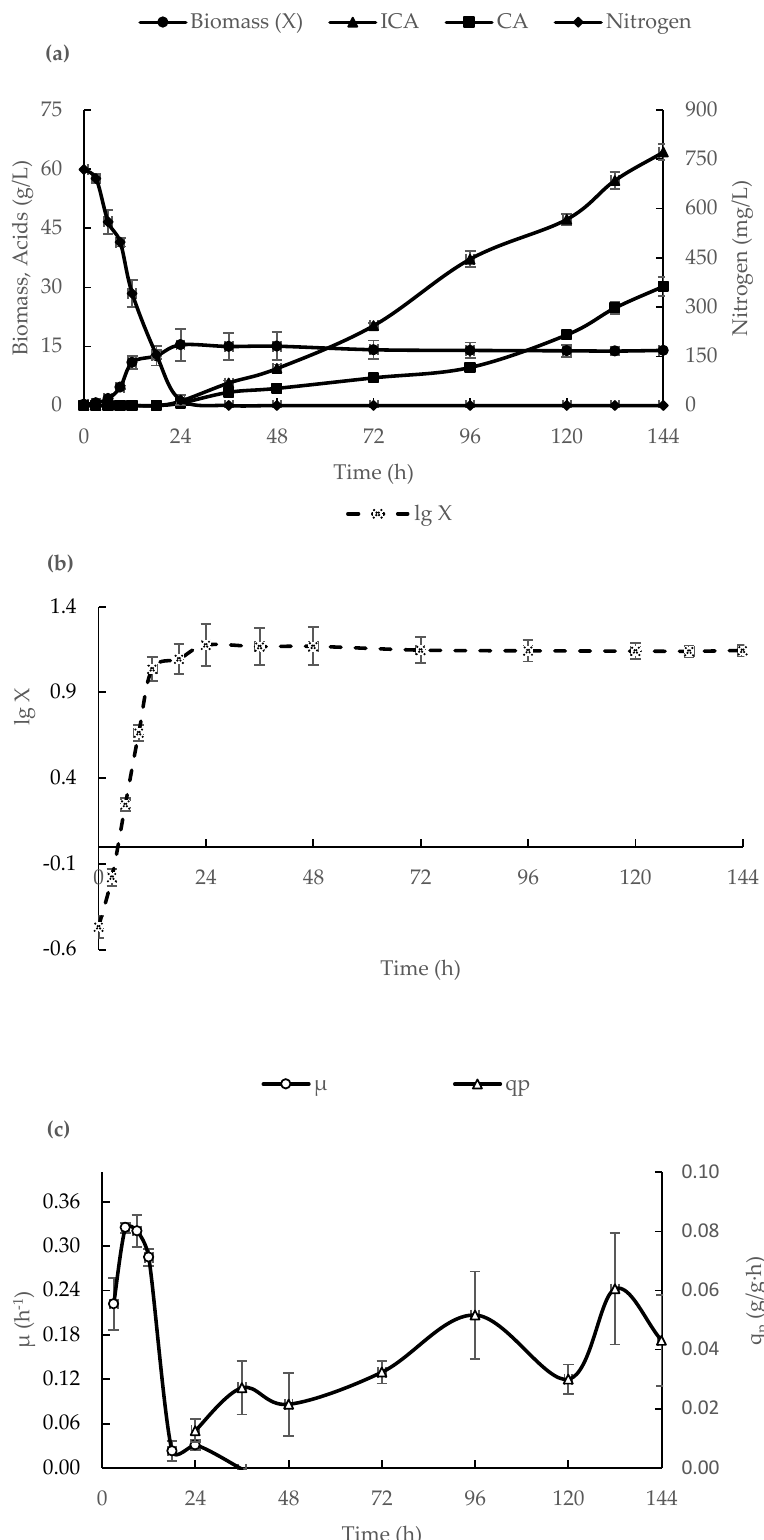
Figure 2. The dynamics of the nitrogen consumption in the medium, biomass (X) accumulation, isocitric acid (ICA), and citric acid (CA) production in Y. lipolytica VKM Y-2373 cultivated in a 10-L fermenter ( a ), the lg X curve ( b ), and the calculated parameters of the specific growth rate ( µ ) and the specific rate of ICA synthesis (qp) ( c ).